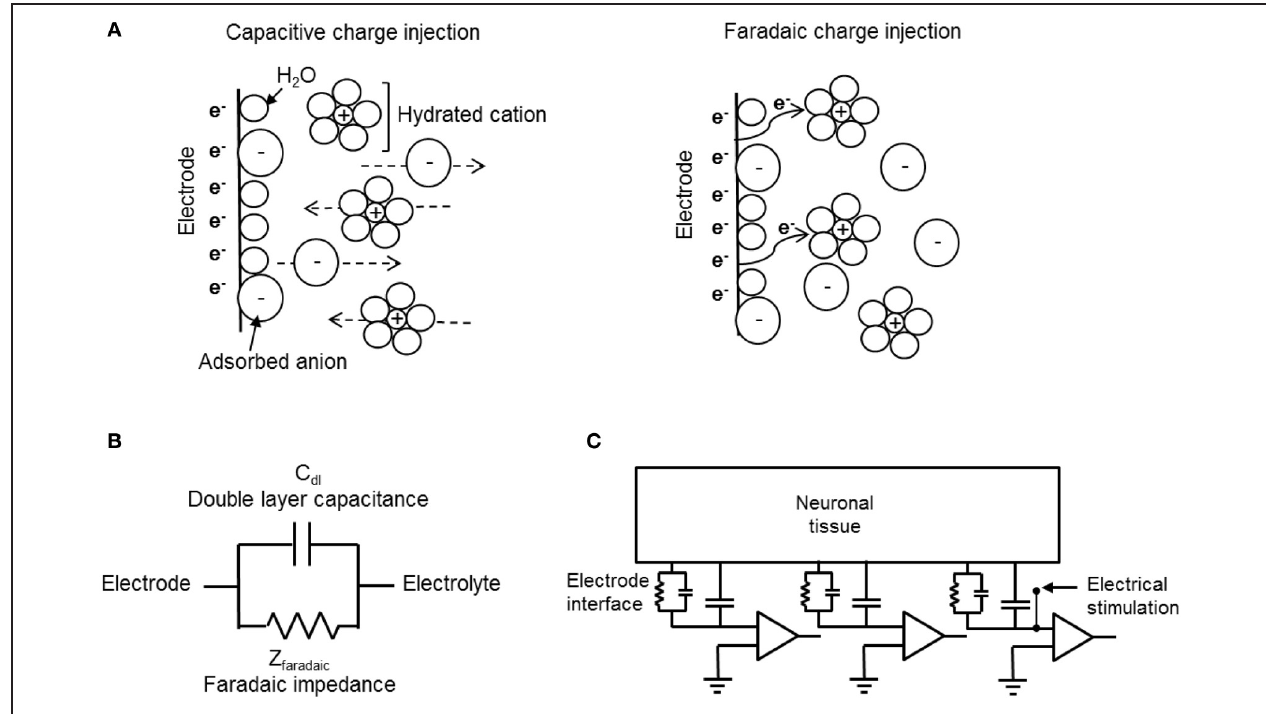
mechanisms of charge transfer at the electrode-electrolyte interface. (C) A circuit model for extracellular recording and stimulation from neuronal tissue using a MEA linked to external amplifiers. The model demonstrates the electrochemical interface resistance and capacitance of the CNT electrode and the solution derived shunt capacitance as well as the point of